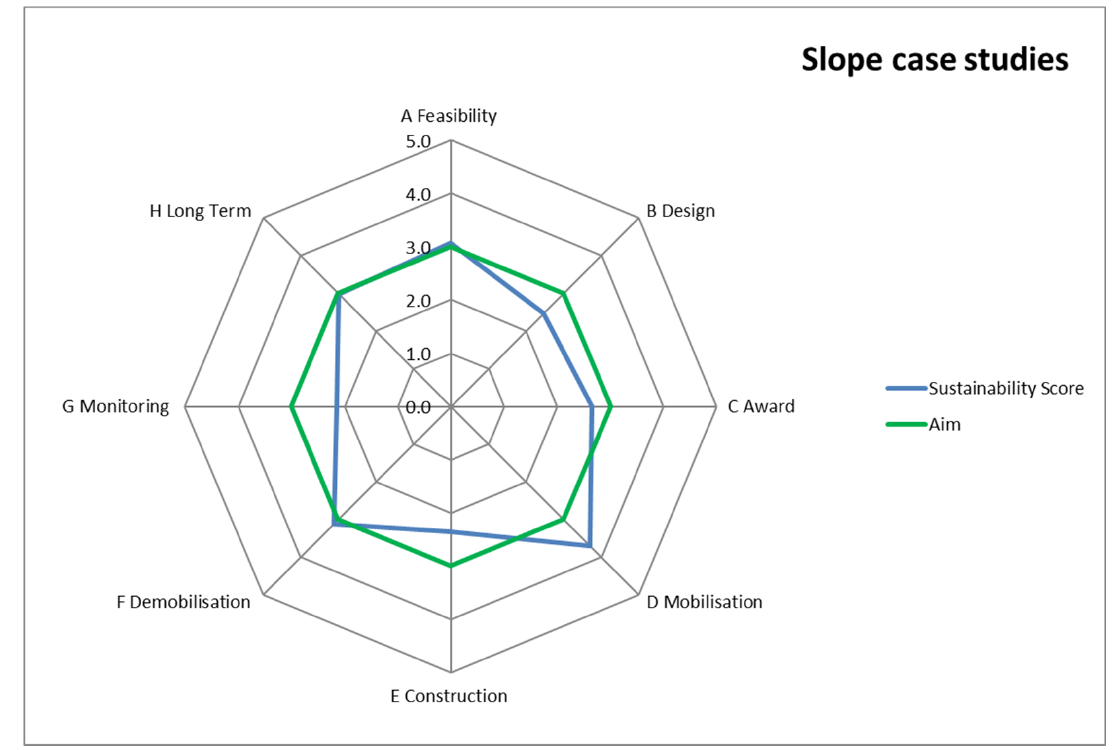
Figure 2. Average scores for hillslope case studies (9).